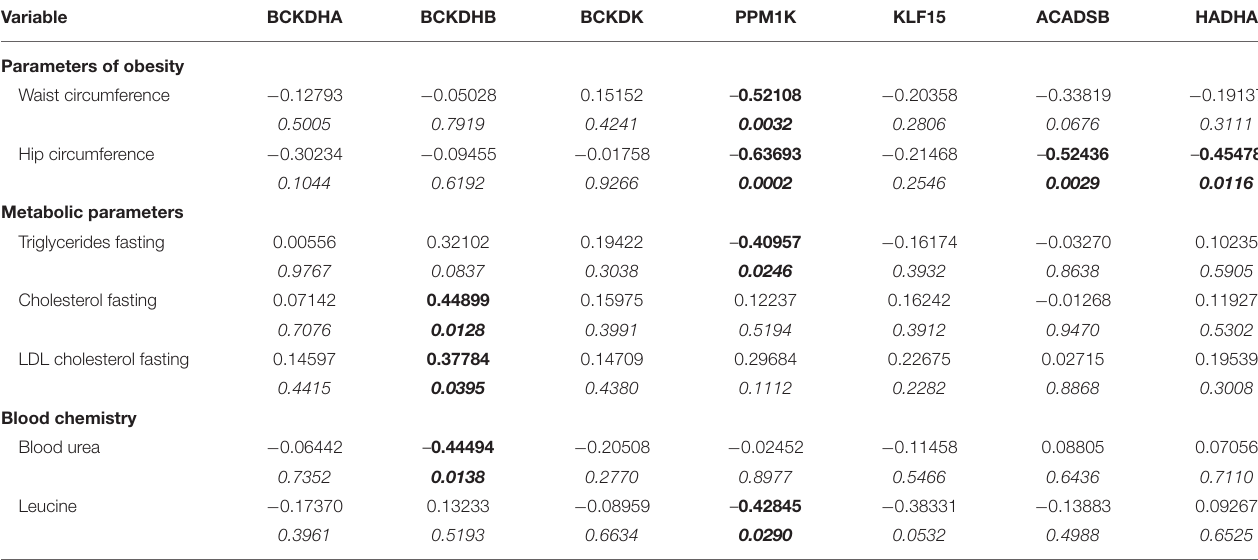
TABLE 3 | Unadjusted Spearman’s correlations for mRNA expression data of BCAA pathway enzyme in SAT from cardiac surgery patients. Variable